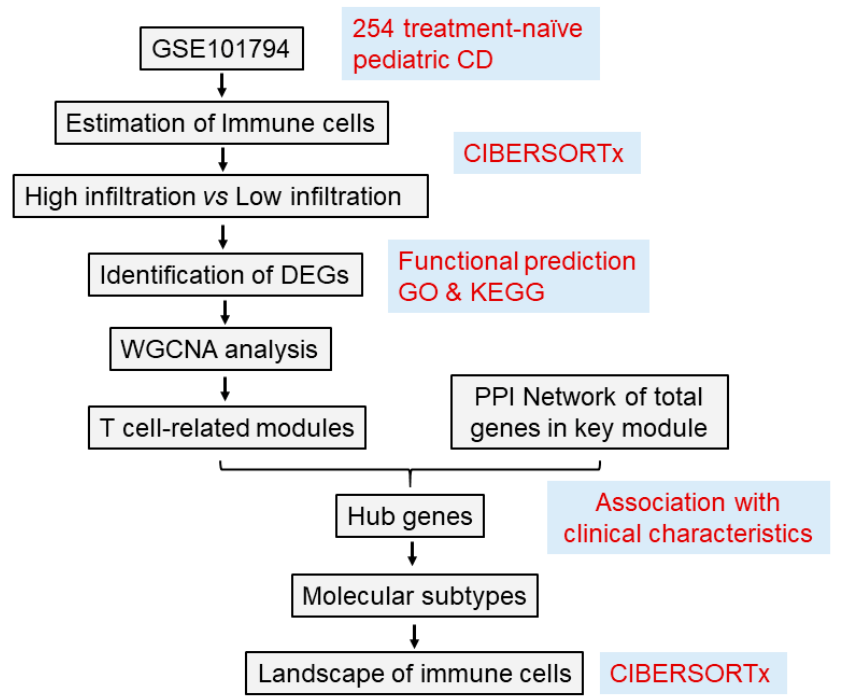
Figure 1. Flow chart of study. CD, Crohn’s disease; GO, Gene Ontology; KEGG, Kyoto Encyclope- dia of Genes and Genomes; WGCNA, weight gene-co-expression network analysis; PPI, protein– protein interaction.